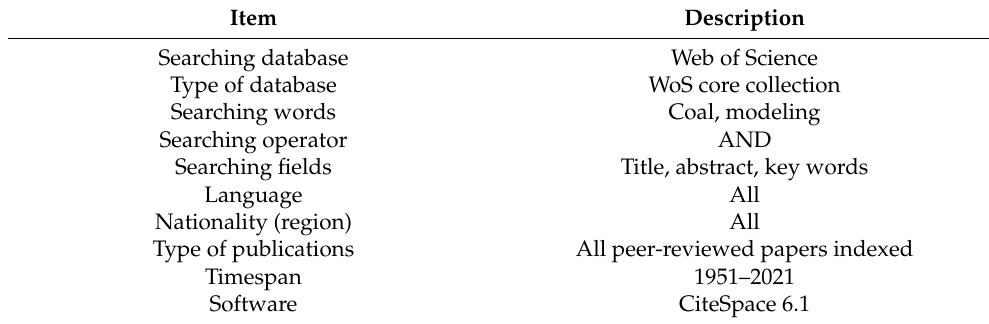
Table 1. Summary of searching design.